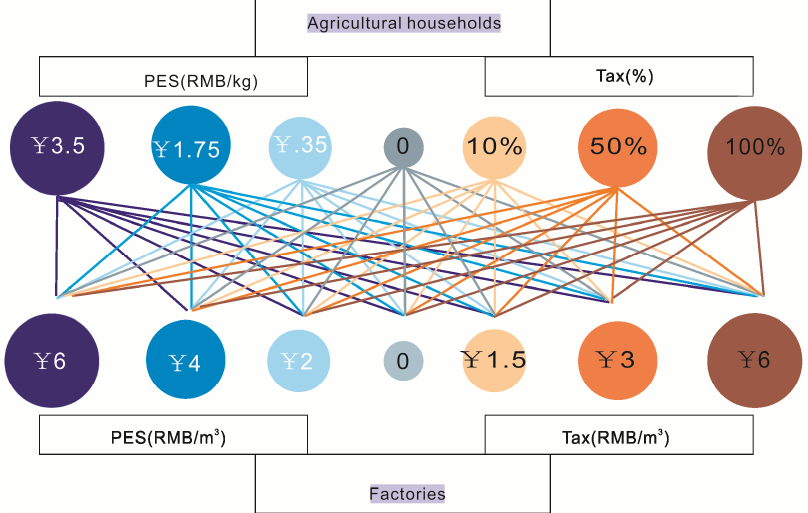
Figure 3. The 49 scenarios used in this study. The upper part of the figure represents the different rates of payments for environmental services (PES) and fertilizer tax implemented for agricultural households and the lower part of the figure represents the different rates of PES and water pollution tax implemented for the factories.